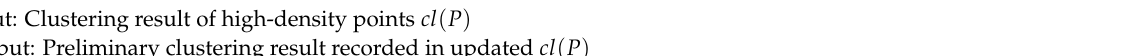
Figure 6. Assignment of remaining data. The left part shows the examples of distances between a point and clusters. The right part shows the preliminary clustering